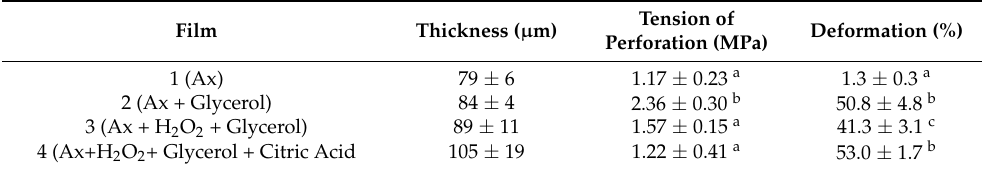
Table 6. Tension of perforation (MPa), deformation (%), and thickness ( µ m) of arabinoxylan films. Values in the same column followed by different superscript letters differ significantly ( p <